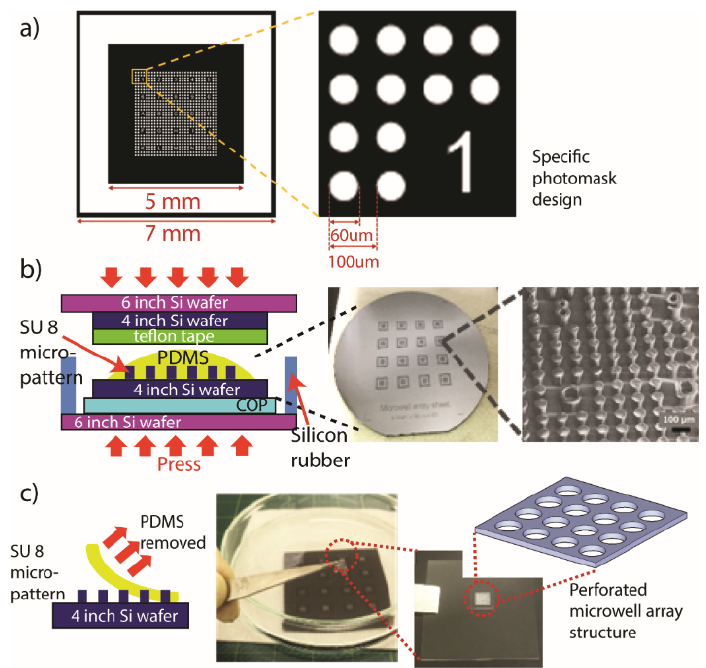
Figure 1. Fabrication of microwell array (MWA) sheet using thermal imprinting method. ( a ) Specific photomask design consists of microwell size of diameter 60 µm and pitch 100 µm was used to produce SU-8 design mold with a thickness of 60 µm height; ( b ) structure assembly before thermal imprinting procedure executed at 0.4 MPa of pressure with at 90 °C for 2 h. ( c ) Cured polydimethylsiloxane (PDMS) layer was carefully removed before replacing on the cover glass until further use.